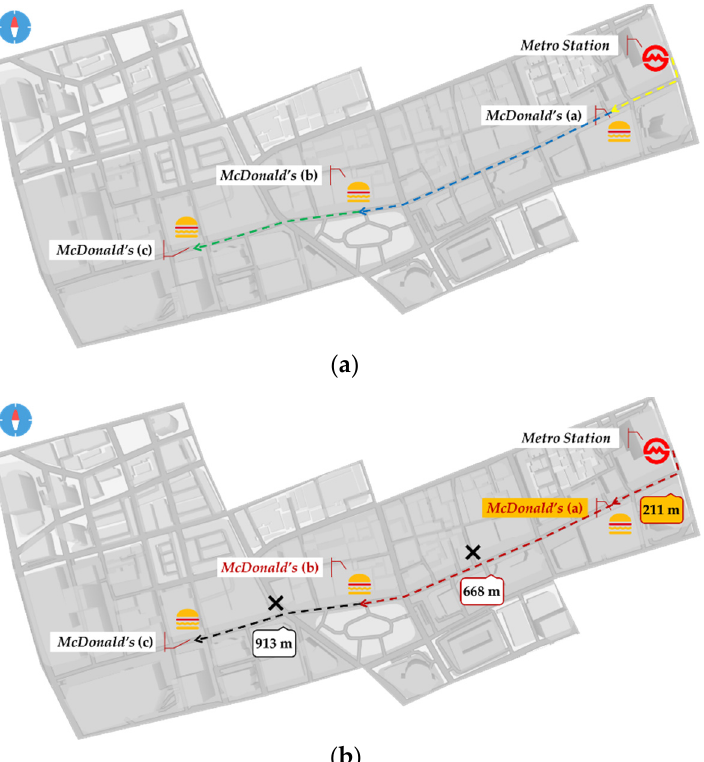
Figure 9. Positioning results of single spatial assertion. ( a ) is the schematic diagram of the path between every McDonald’s storefront and the metro station. ( b ) is a schematic diagram of screening paths that meet the threshold according to the distance relation.